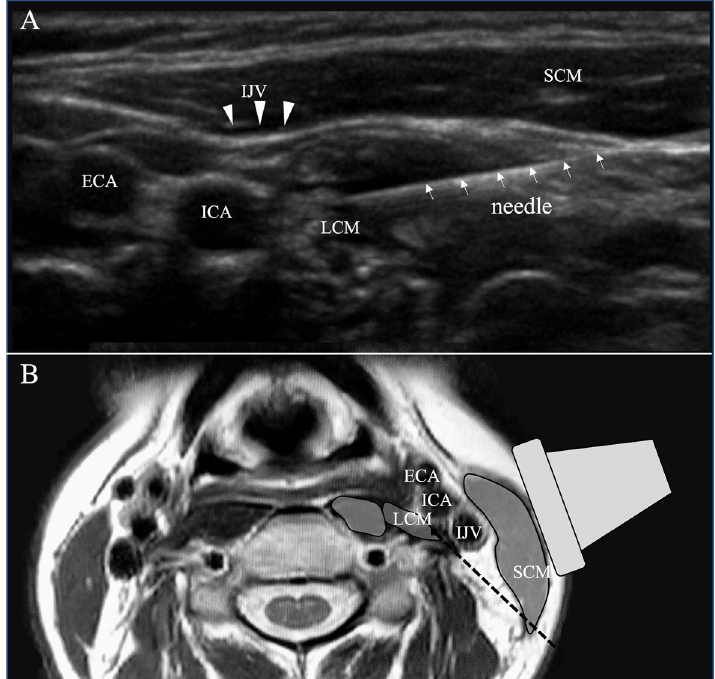
Fig. 1 A represented ultrasound image of the left common carotid bifurcation ( A ) and axial section of T2 weighted magnetic resonance image at approximately the same level ( B ). A A needle (white arrow) is visualized from the right side of the image toward the LCM. The hypoechoic image in the LCM is due to local anesthetic injection. B The black dashed line indicates the expected route of needle insertion. ICA, internal carotid artery; ECA, external carotid artery; IJV, internal jugular vein (white arrowheads); LCM, longus capitis muscle; SCM, sternocleidomastoid